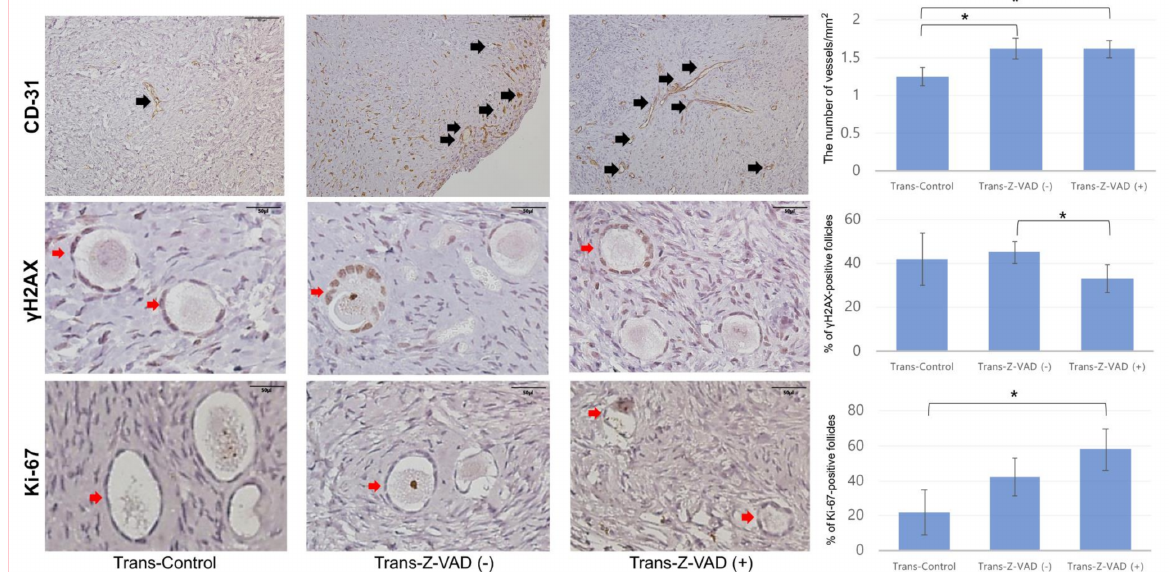
Figure 4. Histological features of human ovarian tissues after xenotransplantation in the three groups evaluated with immunohistochemical staining for CD-31 (magnification × 400, control: n = 10, Trans-Z-VAD (-): n = 19, Trans-Z-VAD ( + ): n = 20, * p < 0.05), Ki-67 (magnification × 400, control: n = 9, Trans-Z-VAD (-): n = 19, Trans-Z-VAD ( + ): n = 18, * p < 0.05), and γ H2AX (magnification × 400, control: n = 10, trans-Z-VAD (-): n = 18, trans-Z-VAD ( + ): n = 18, * p < 0.05). Black arrows indicate CD-31-stained cells. Red arrows indicate Ki-67/ γ H2AX-positive primordial